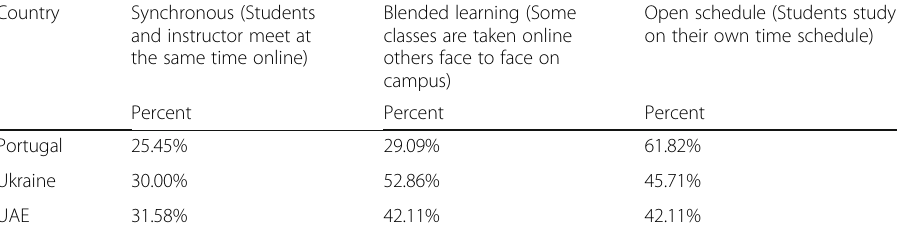
Blended learning (Some classes are taken online others face to face on campus)